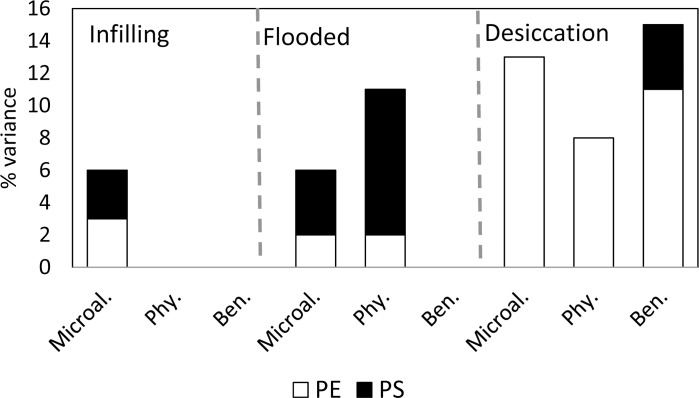
Adjusted variance (% adjR2) explained by pure environmental (PE) or pure spatial (PS) factors on the structure of the selected matrices of all microalgae (Microal.), the phytoplankton (Phy.) and benthic (Ben.) fractions for each hydrological period (infilling, flooded, desiccation).